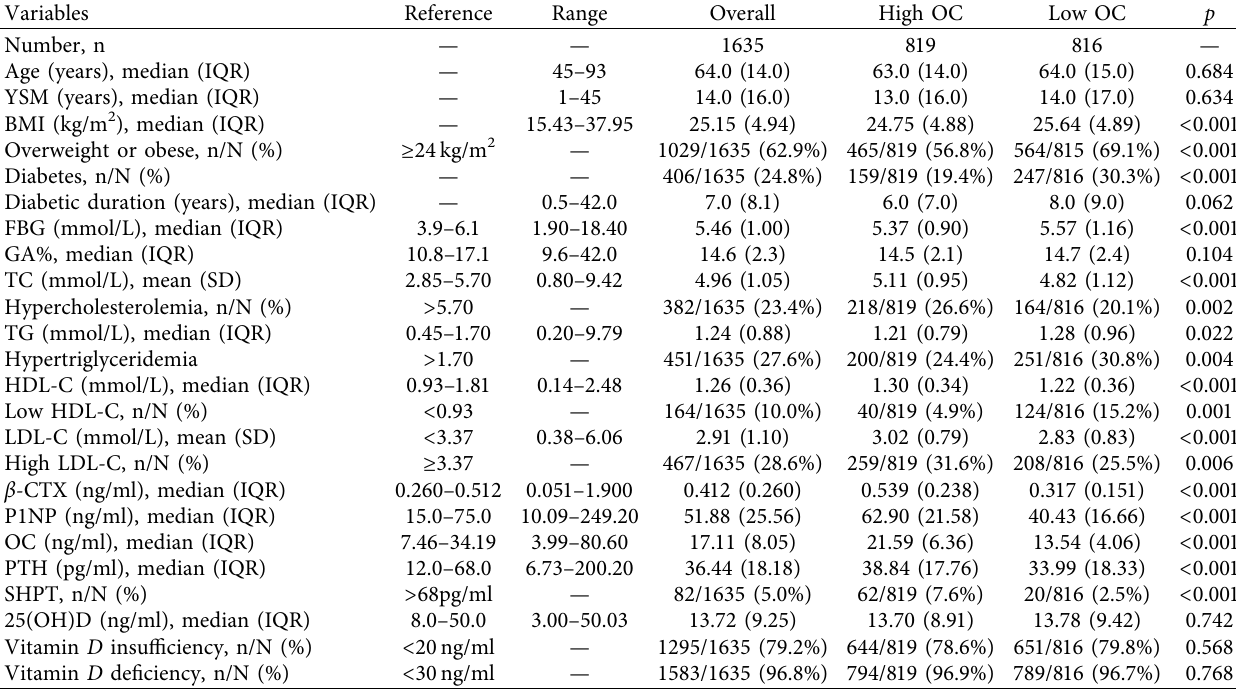
Table 1: Baseline characteristics between groups classified by the median level of